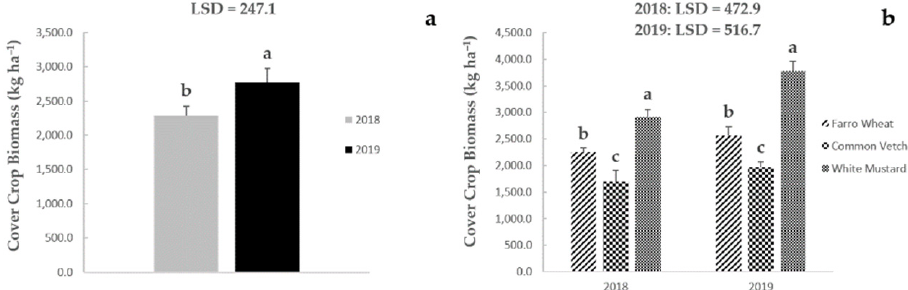
Figure 1. Cover crop biomass production (kg ha − 1 ) in 2018 and 2019 before the 2018–2020 and 2019–2021 sulla growing cycles, respectively, averaged ( a ) across all species and ( b ) per species. Different lowercase letters indicate significant differences. Vertical bars indicate standard errors.